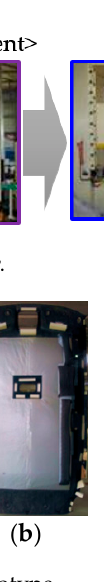
Figure 10. Headliner: ( a ) Modeling; ( b ) Prototype.